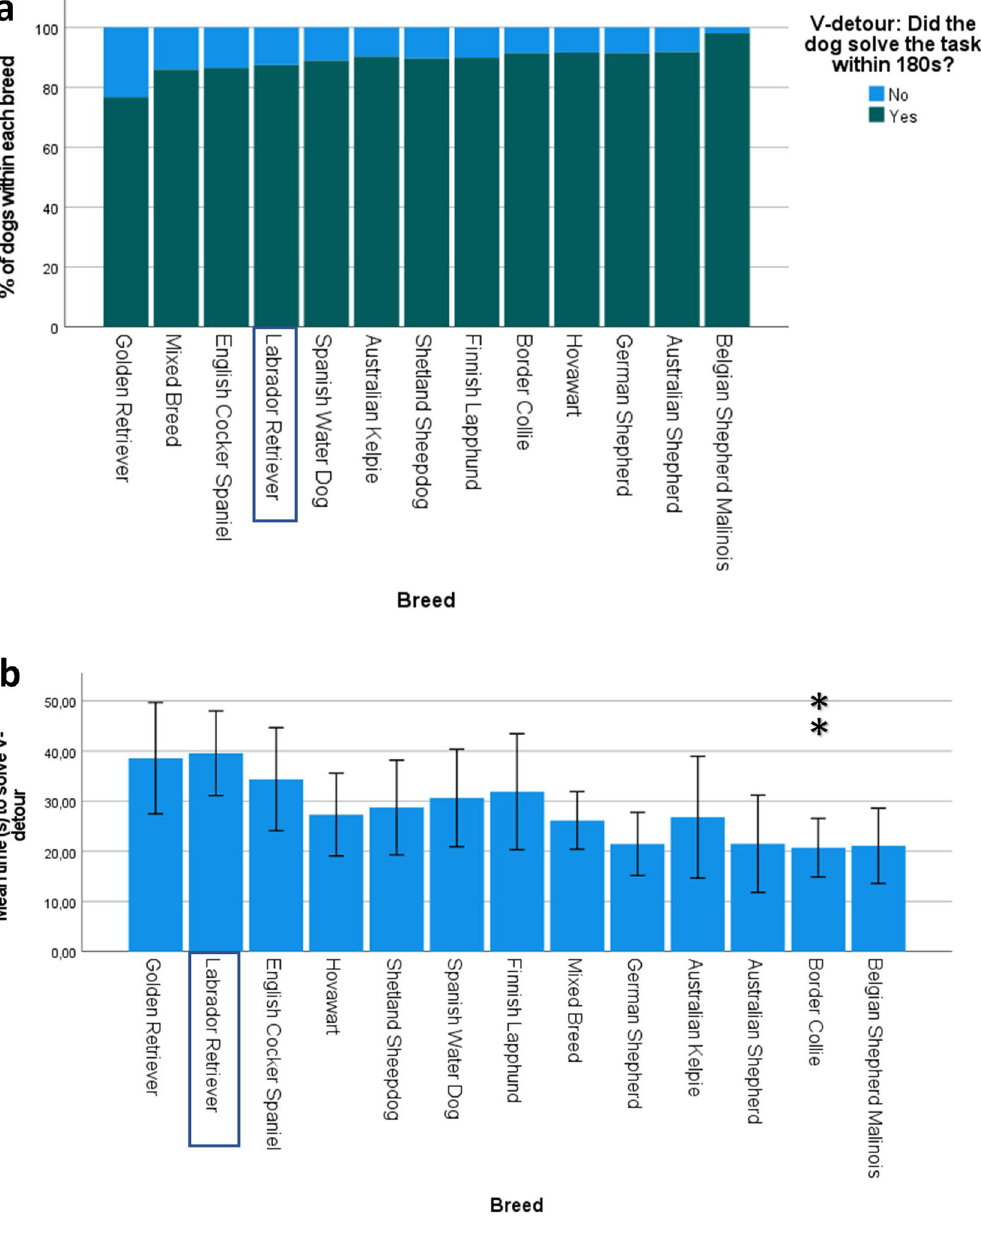
Figure 4. Performance of dogs during the V-detour task. The Labrador Retriever was used as the reference breed. Significant P-values (Bonferroni-corrected) are indicated with asterisks: ***p ≤ 0.001, **p ≤ 0.01, *p ≤ 0.05. ( a ) Percentage of dogs within each breed succeeding vs failing in the V-detour task (n = 993). Breeds have been ordered based on B-values, with lowest succeeding breeds on the left and highest succeeding breeds on the right. ( b ) Mean latency (s) to solve the V-detour for each breed are presented using the untransformed, original data (n = 863). Error bars represent 95% confidence intervals. Breeds are ordered based on B-values, with lowest succeeding breeds (took a long time to solve the task) on the left and highest succeeding breeds (solved the task quickly) on the